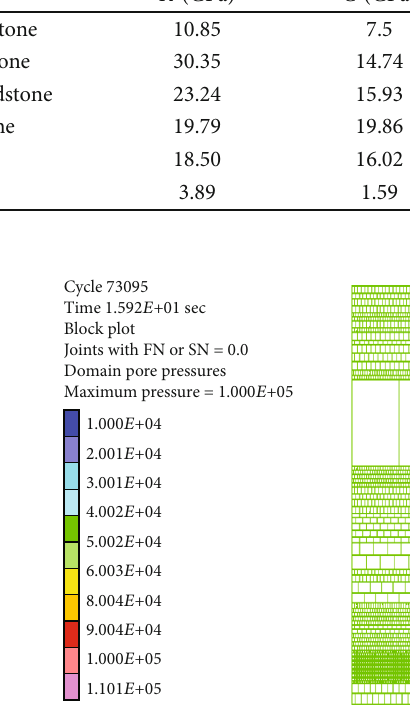
Figure 2: The pore pressure distribution in initial caving of direct